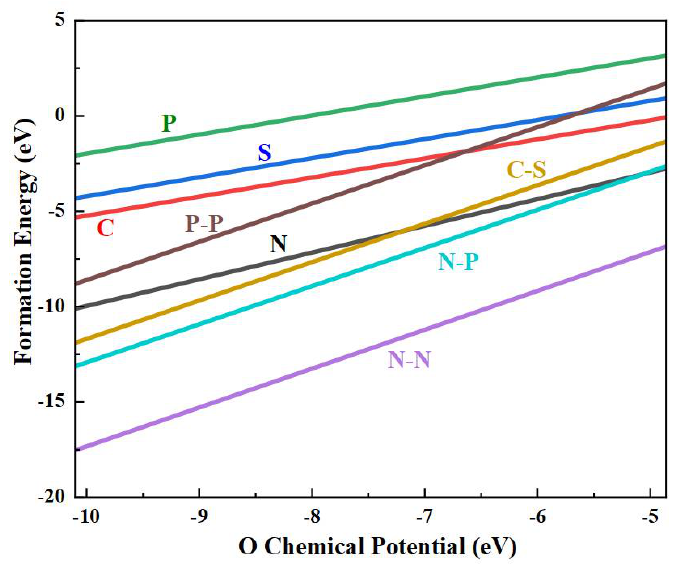
Figure 2. Estimated energies of formation in respect to the oxygen chemical potential for anionic mono- and anionic-anionic co-doped